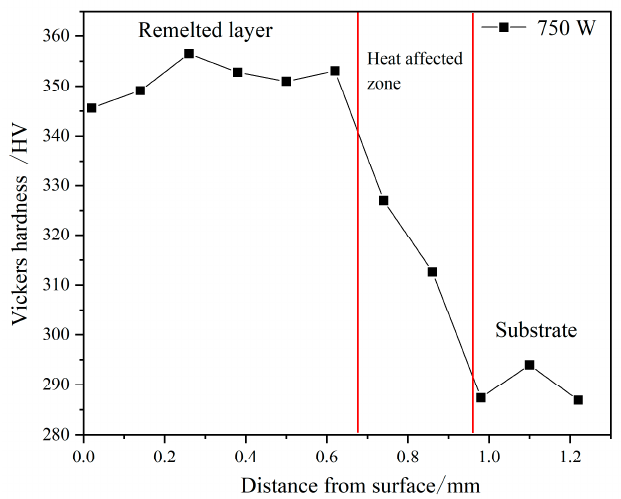
Figure 4. Vickers hardness gradient of cross-section after laser remelting.